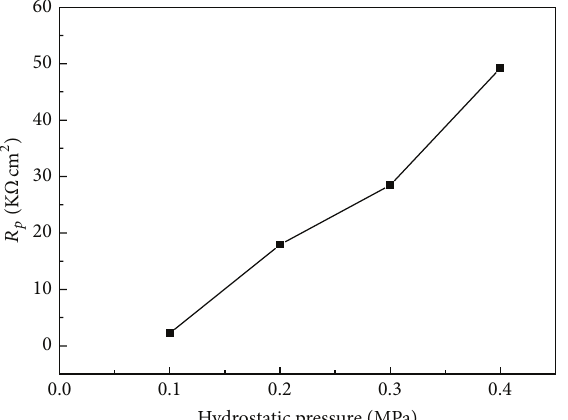
Figure 9: Evolution of 𝑅 𝑝 estimated by linear polarization curves under different hydrostatic pressure in CRS solution at 293 K after 2 days.